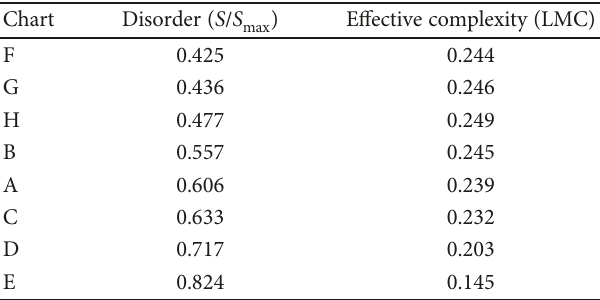
Table 7: E ff ective complexity calculation and ranking for each